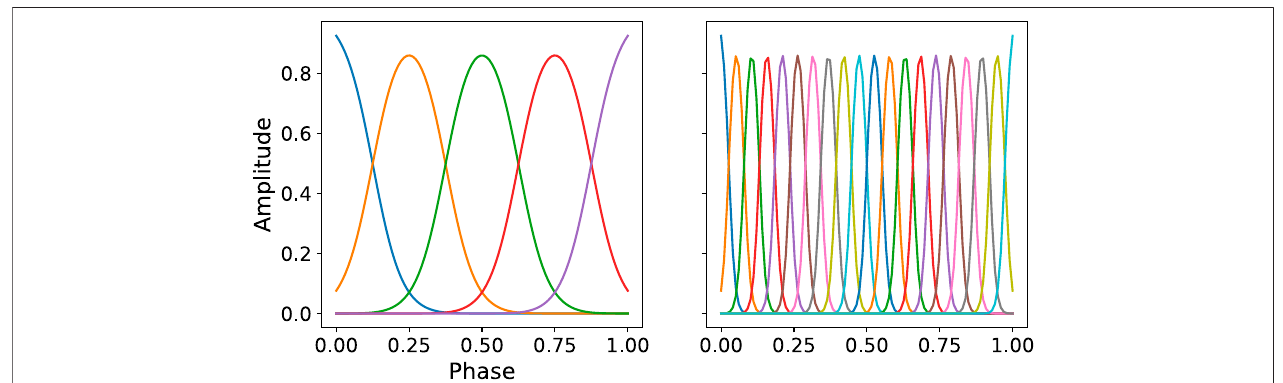
FIGURE 1 | Illustration of the distribution of basis function. Left: M (cid:1) 5, Right: M (cid:1) 20. The bandwidth parameter is computed by h (cid:1) 0 . 2 · ( c i + 1 − c i ) 2 to ensure an overlap between neighboring basis functions.